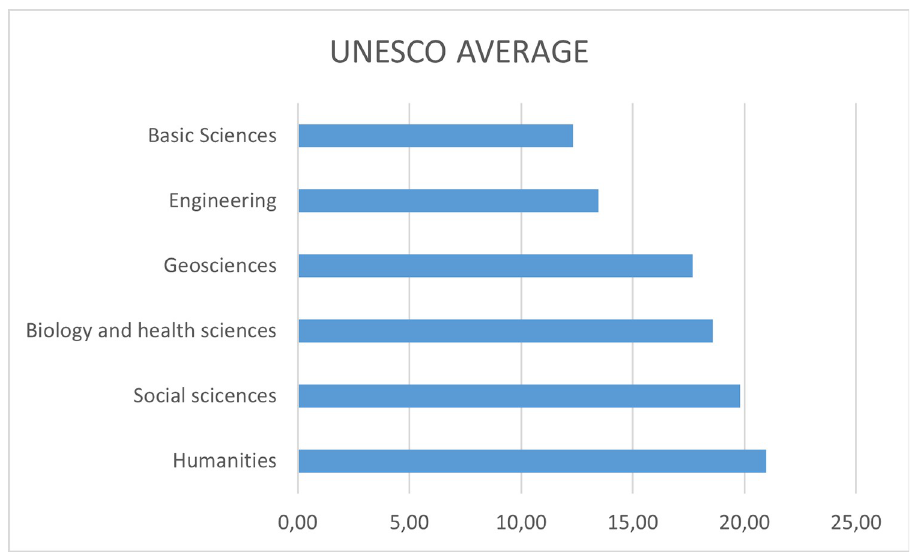
Fig 8. Non-inclusiveness indicator along the different UNESCO codes.